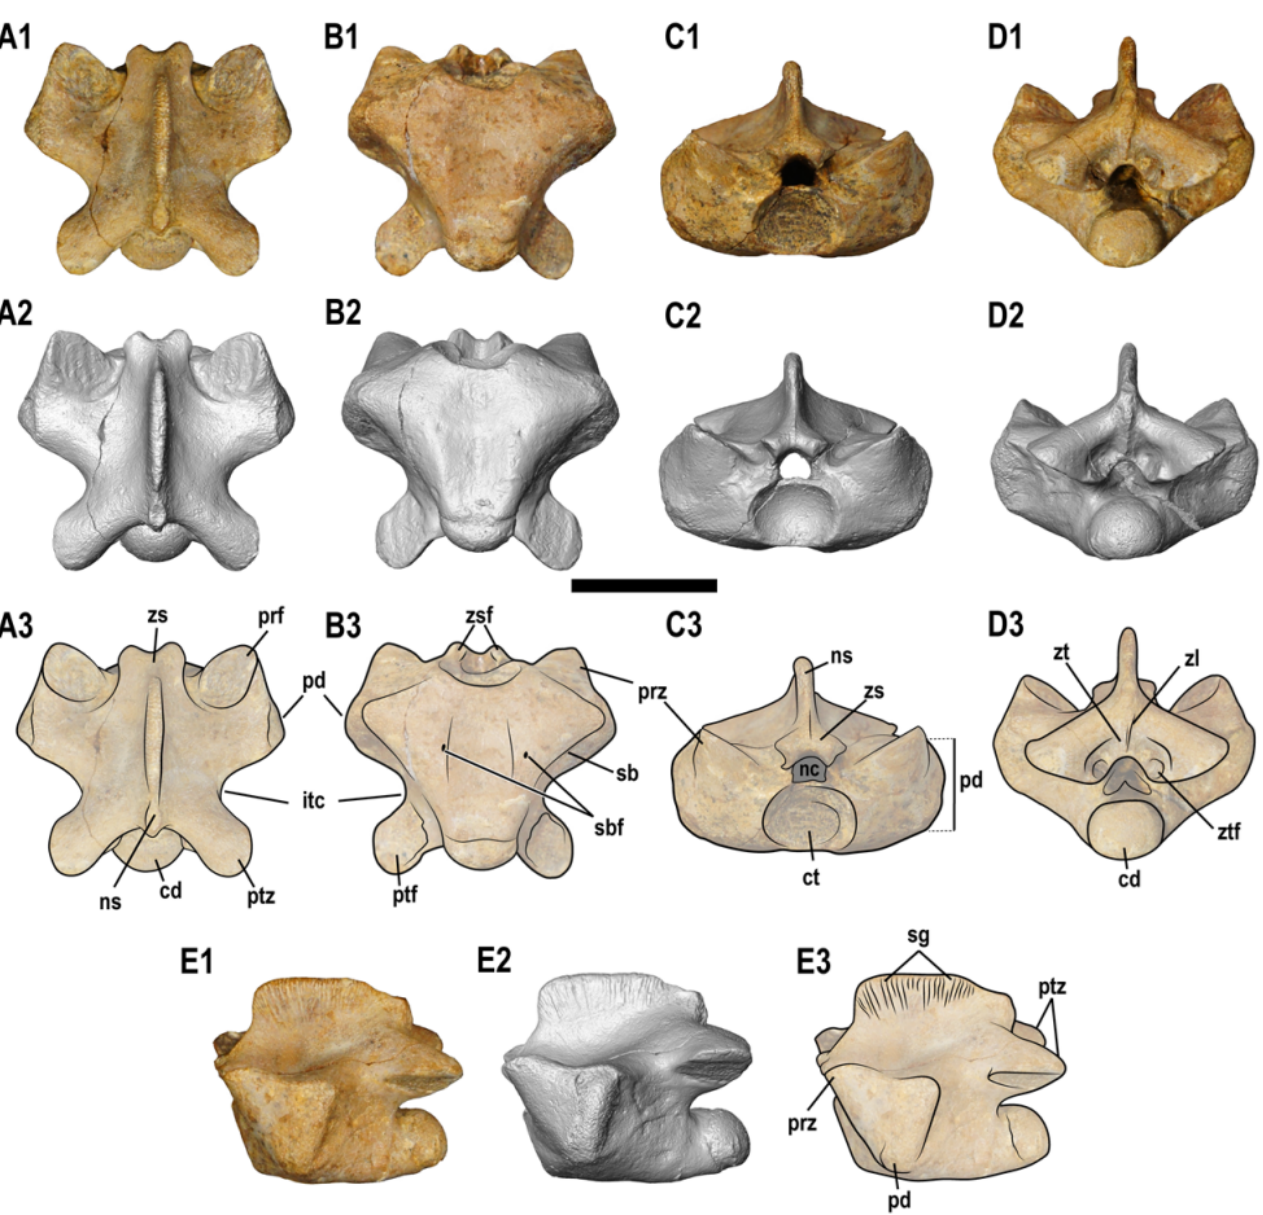
Figure 3. ALG 200, holotype of Carentonosaurus algorensis sp. nov., from the uppermost middle to lowermost upper Cenomanian site of Algora (Guadalajara Province, Central Spain). Photo of the original material ( A1 – E1 ), 3D model ( A2 – E2 ), and interpretative drawings on the photos ( A3 – E3 ); in dorsal ( A ), ventral ( B ), cranial ( C ), caudal ( D ), and lateral ( E ) views. Scale bar: 10 mm. Type species. Carentonosaurus mineaui Rage and N é raudeau, 2004